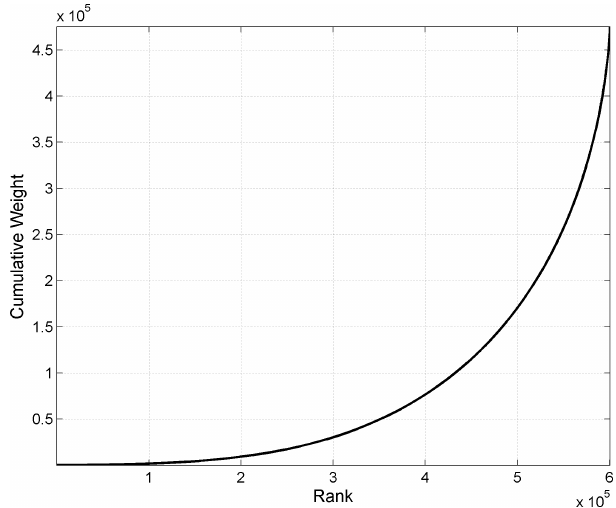
Figure 9. Cumulative weights of the 600463 condensed KaKiOS- 16 components representing a total of 479056 events. The compo- nents are ranked according to increasing